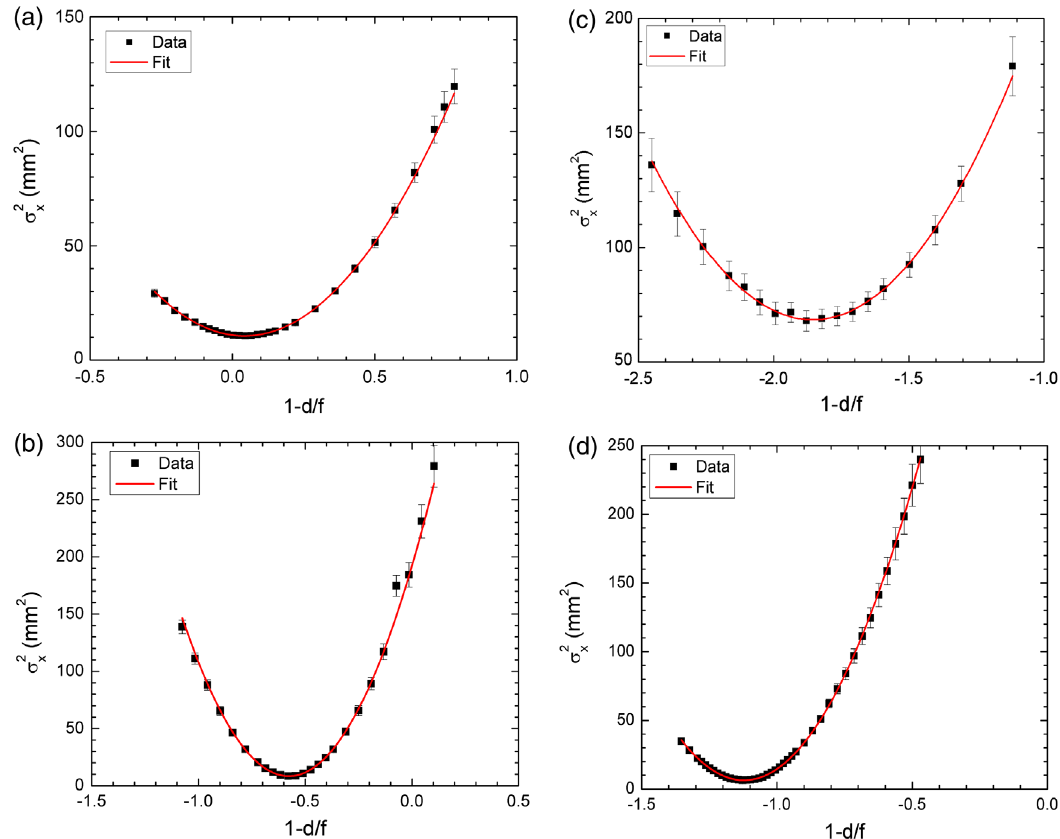
FIG. 14. Squares of rms beam size versus focusing strength using Eq. (2). (a) At PWC005. (b) At PWC014. (c) PWC021 and PWC025. The red curve is a parabolic fit to the